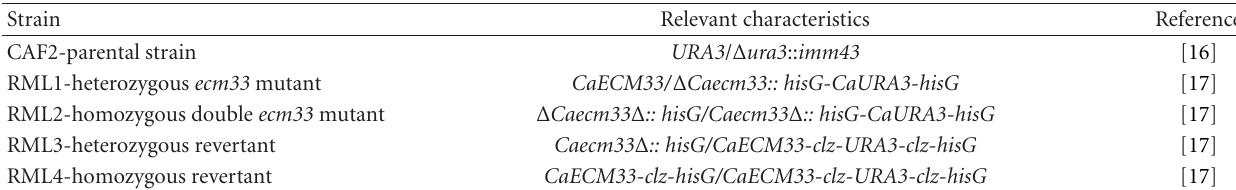
Table 1: Candida strains used in this study.